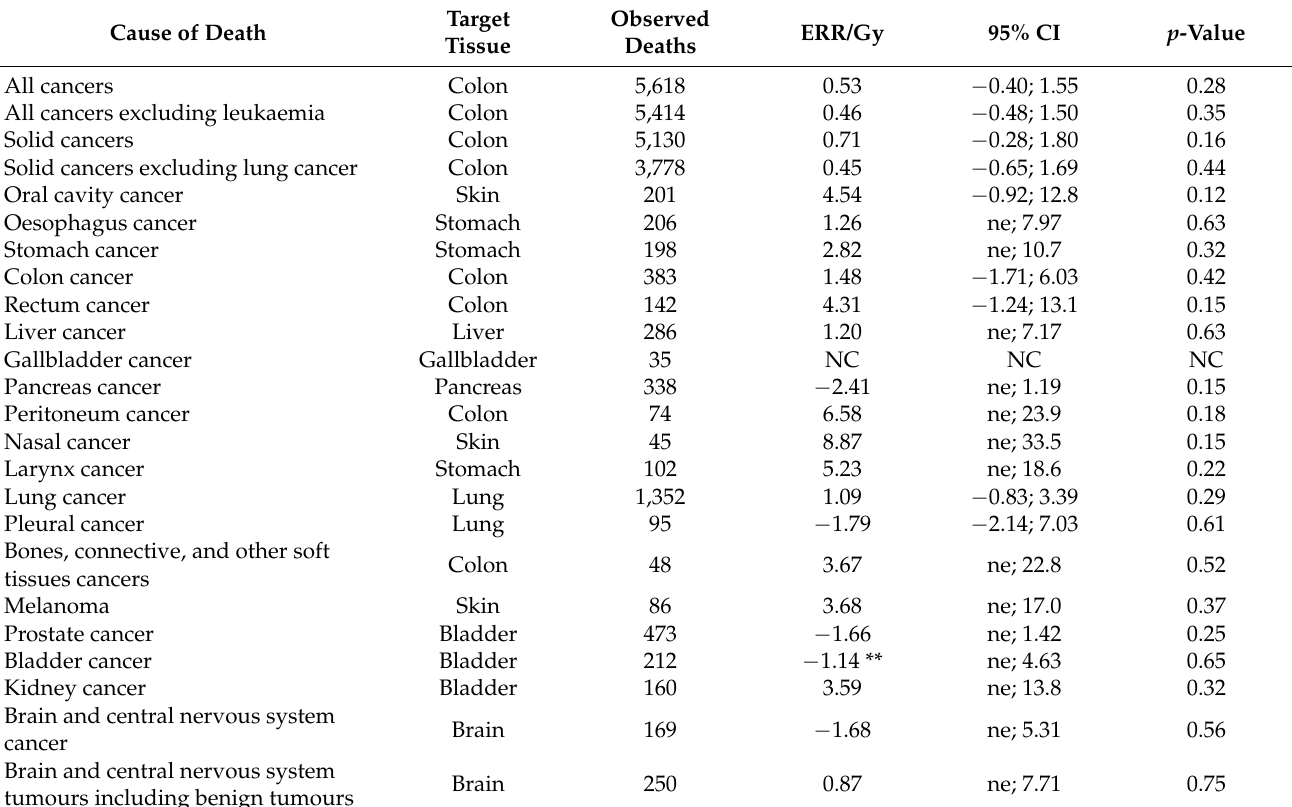
Table 2. Excess relative rates * of death from solid cancers (including specific cancer sites) per Gray (ERR/Gy) of 10-year lagged cumulative dose absorbed to target tissues in males only, SELTINE cohort, period